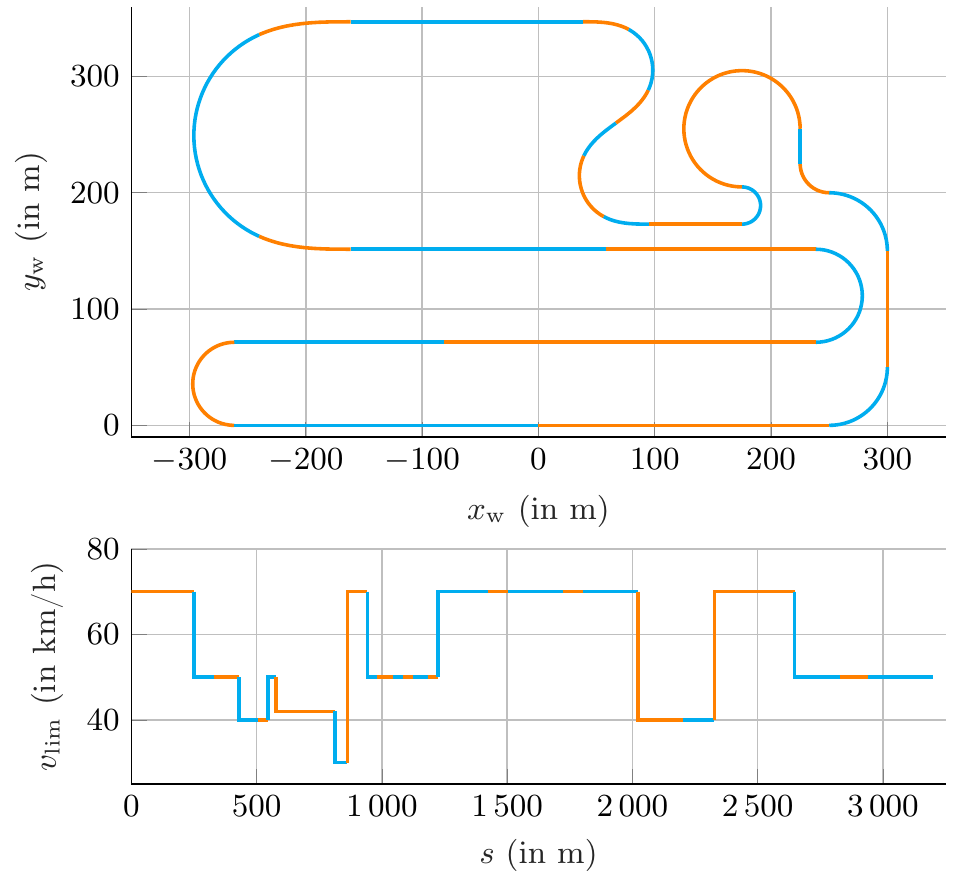
Figure 3. 2D view of the target line and the speed limit v lim of the circular track used in the simulation. The different sections of the target line are highlighted by the colors cyan and orange for clarity.